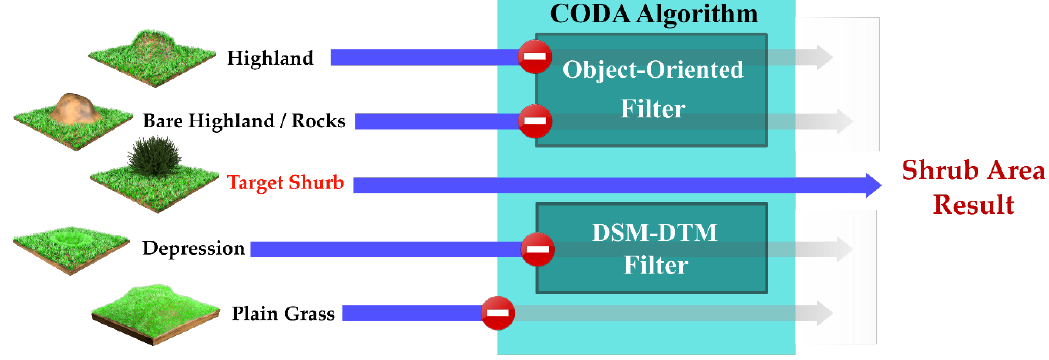
Figure 9. Why is the accuracy of CODA is higher than that of OOF and DSM-DTM?